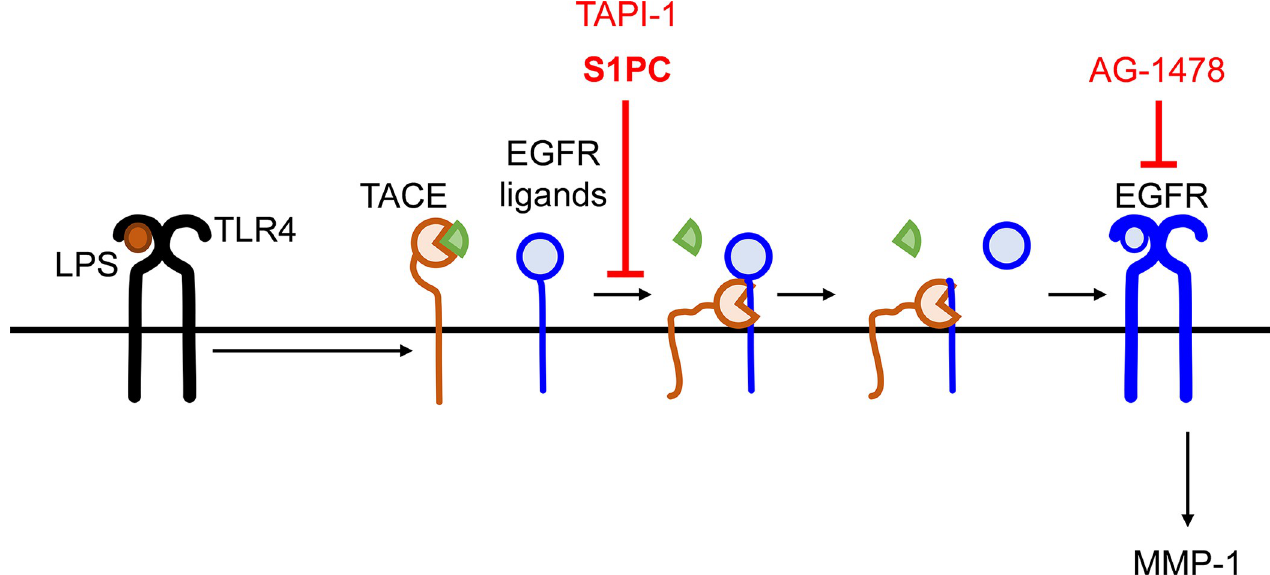
Fig 5. A proposed mechanism by which S1PC suppressed the LPS-induced MMP-1 expression in human gingival fibroblasts. The binding of LPS to TLR4 activates TACE and this activation promotes the phosphorylation of EGFR to induce the expression of MMP-1 in HGF-1 cells. Both EGFR tyrosine kinase and TACE inhibitors, AG-1478 and TAPI-1, antagonize the LPS-induced expression of MMP-1. S1PC suppresses the LPS-induced activation of TACE and subsequent phosphorylation of EGFR, thus ultimately suppressing the expression of MMP-1. TACE: tumor necrosis factor- α converting enzyme, EGFR: epidermal growth factor receptor, LPS: lipopolysaccharide, MMP-1: matrix metalloproteinase-1, S1PC: S -1-propenyl-L-cysteine, TLR4: toll-like receptor 4.